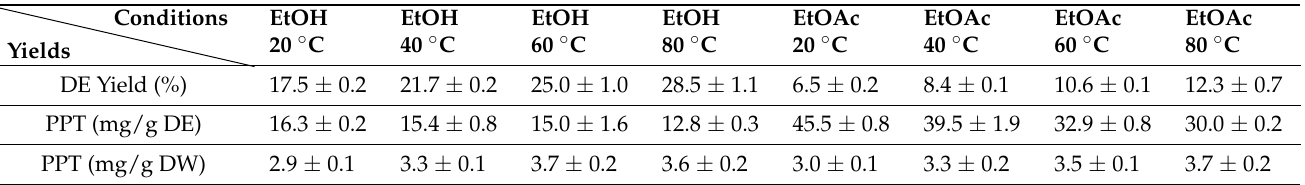
Table 5. Effects of the solvent and temperature on the PPT recovery by accelerated solvent extraction of J. virginiana leaves.